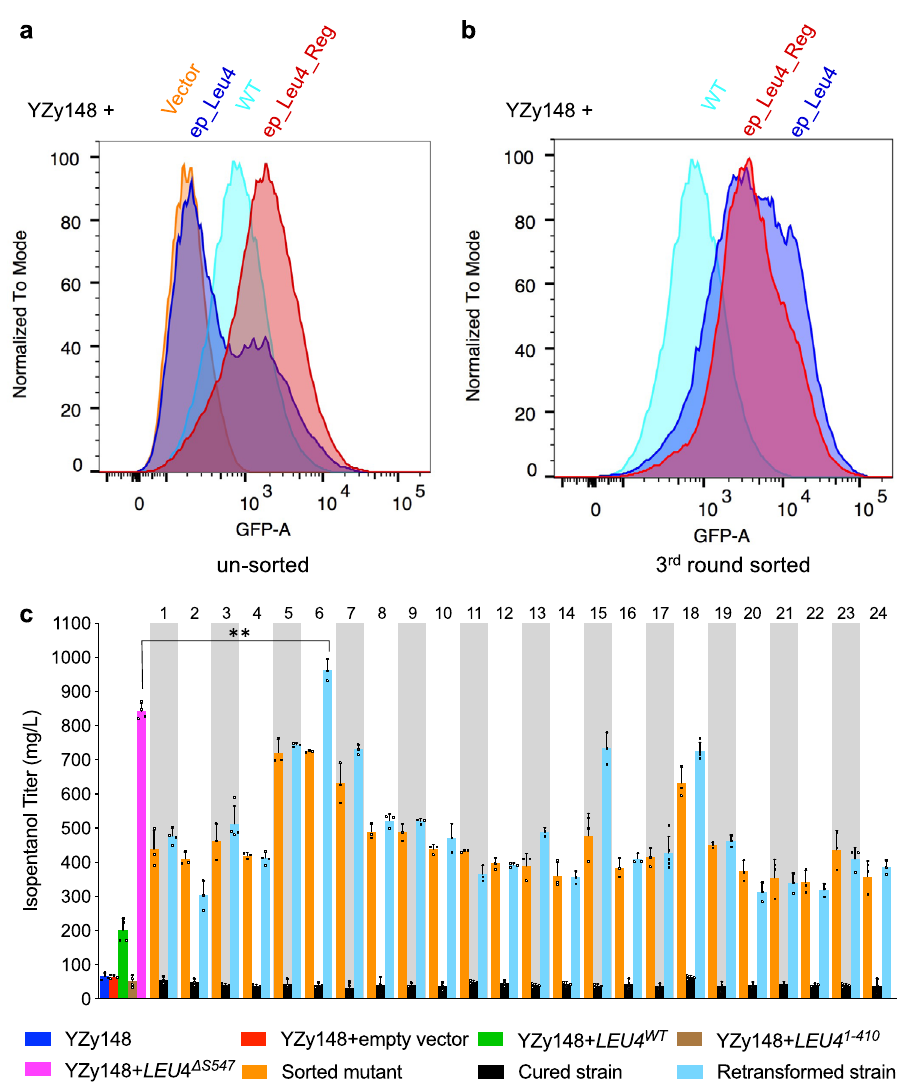
Fig. 4 High-throughput screen for hyperactive Leu4p variants using the isopentanol con fi guration of the biosensor. a Flow cytometry analysis of yeast libraries containing LEU4 variants generated with error-prone PCR-based mutagenesis of the full-length LEU4 (ep_Leu4, blue) or only the LEU4 regulatory domain (ep_Leu4_Reg, red), compared to control strains containing an empty vector (Vector, orange) or wild-type LEU4 (WT, cyan). Cell populations were normalized to the mode for comparison. b Flow cytometry analysis of the same libraries depicted in ( a ) after three rounds of FACS. c Isopentanol titers after 48 h fermentations of sorted strains with unique LEU4 sequences (orange), plasmid-cured derivatives (black), and strains obtained from retransforming YZy148 with each unique plasmid isolated from the corresponding sorted strain (cyan). Titers obtained from the basal strain YZy148 ( leu4 Δ leu9 Δ bat1 Δ LEU2 ) with (red) or without (blue) an empty vector, or transformed with plasmids containing wild-type LEU4 ( LEU4 WT , green), LEU4 1 – 410 (brown), or LEU4 Δ S547 (magenta), are shown as controls. The numbers on the upper x-axis identify each strain harboring a unique LEU4 sequence. LEU4 mutants 1 – 13 are derived from mutagenizing the full-length LEU4 ; and mutants 14 – 24 from mutagenizing the LEU4 leucine regulatory domain. All data are shown as mean values. Open circles represent individual data points. Error bars represent the standard deviation of at least three biological replicates. A two-sided t -test was used to determine the statistical signi fi cance of the difference between isopentanol titers achieved by YZy148 transformed with a plasmid containing LEU4 Δ S547 (magenta), or LEU4 mutant #6 ( LEU4 E86D_K191N_K374R_A445T_S481R_N515I_A568V_S601A ). P = 0.0021; ** P ≤ 0.01. Source data are provided as a Source Data fi